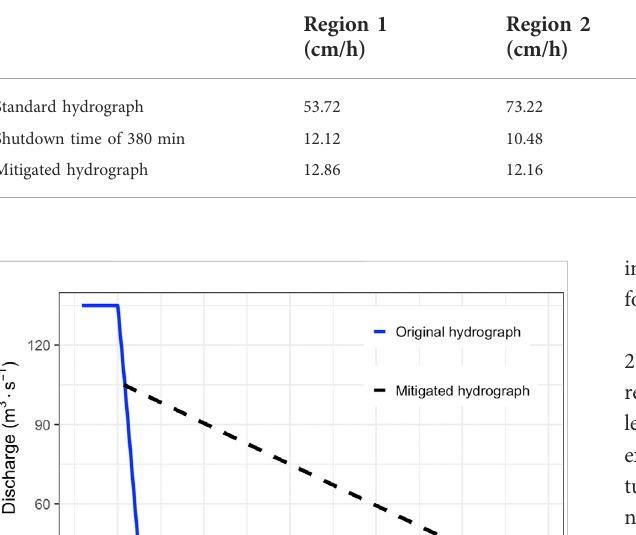
TABLE 1 Average dewatering rates for the original hydrograph, a hydrograph with a shutdown time of 380 min, and the mitigated hydrograph (Figure 8). The acceptable dewatering rate is 13 cm/h.